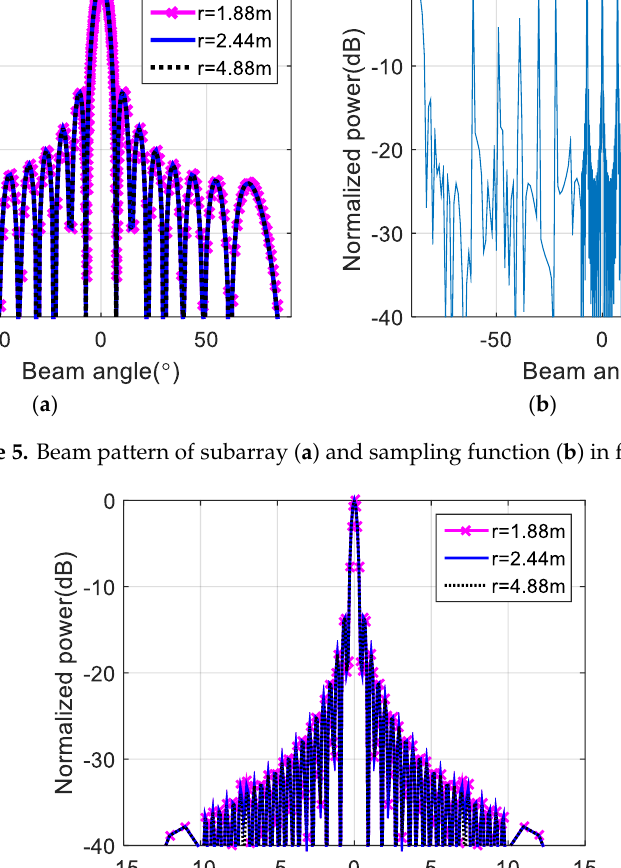
Figure 6. Beam pattern estimated by the proposed method.